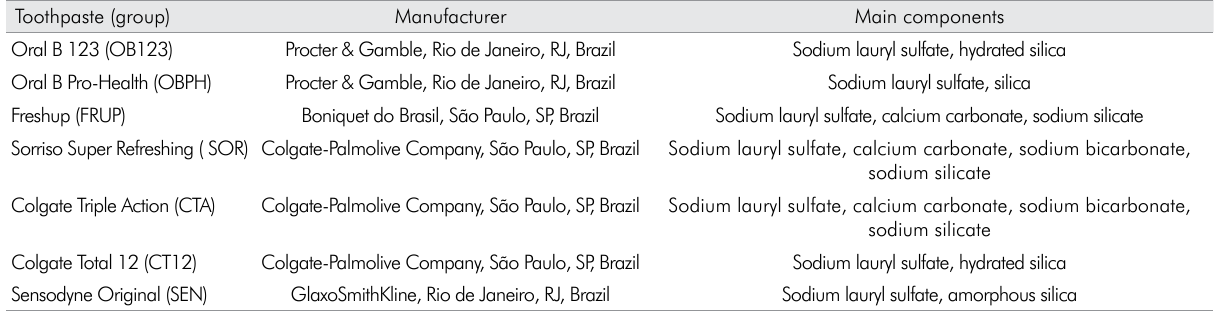
Table. Toothpastes, their respective manufacturers and their main components. Toothpaste